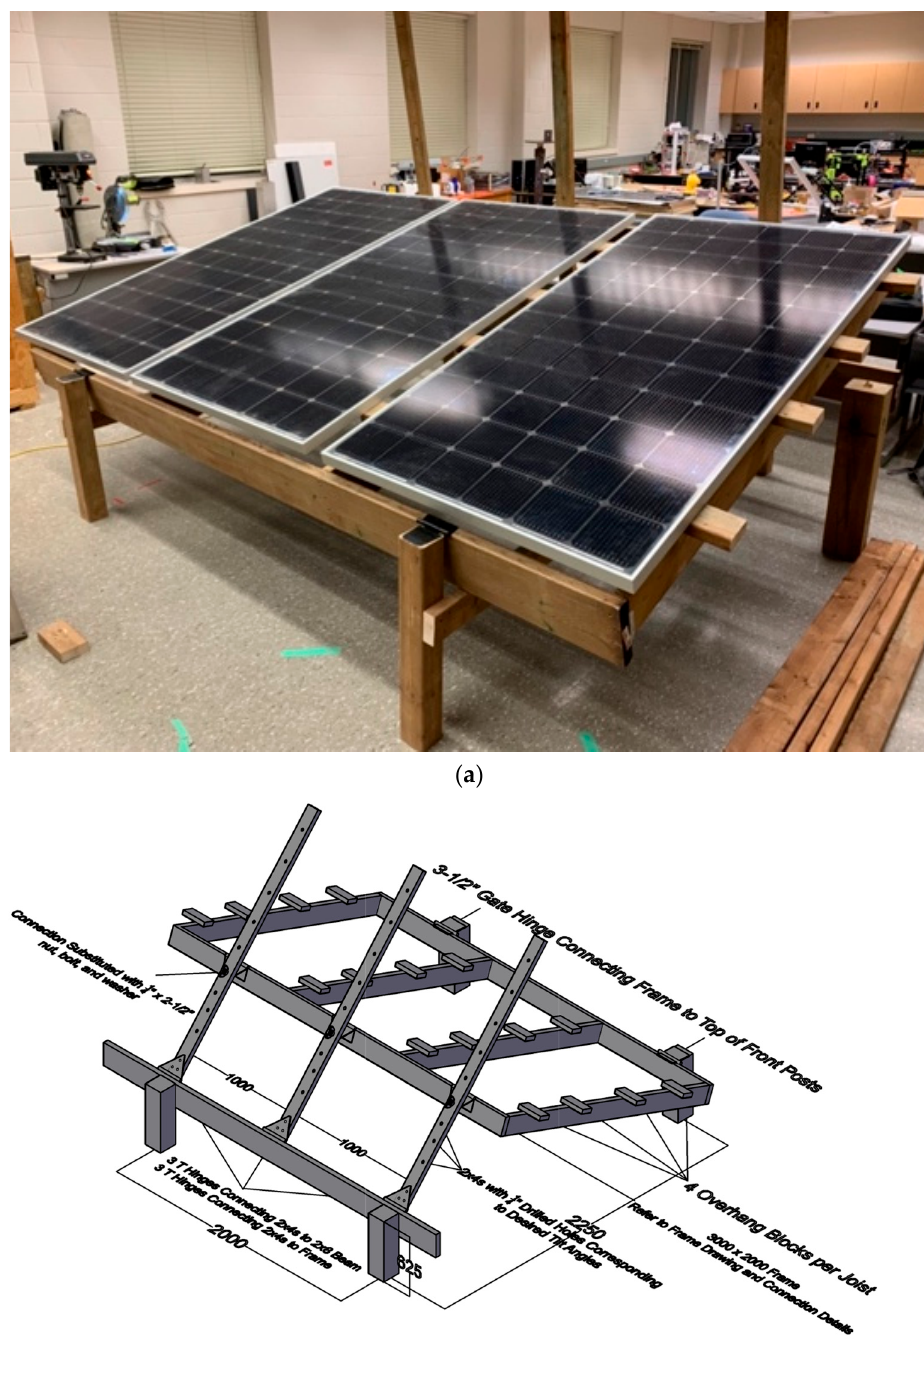
Figure 8. ( a ) Finished system, and ( b ) detailed back view of the final system.